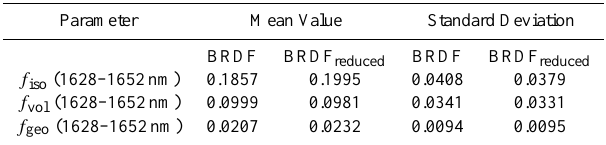
Table 2. Statistical comparison between original and reduced ran- dom number BRDF distribution weighting parameters ( f iso , f vol , f geo ) for the B6 wavelength